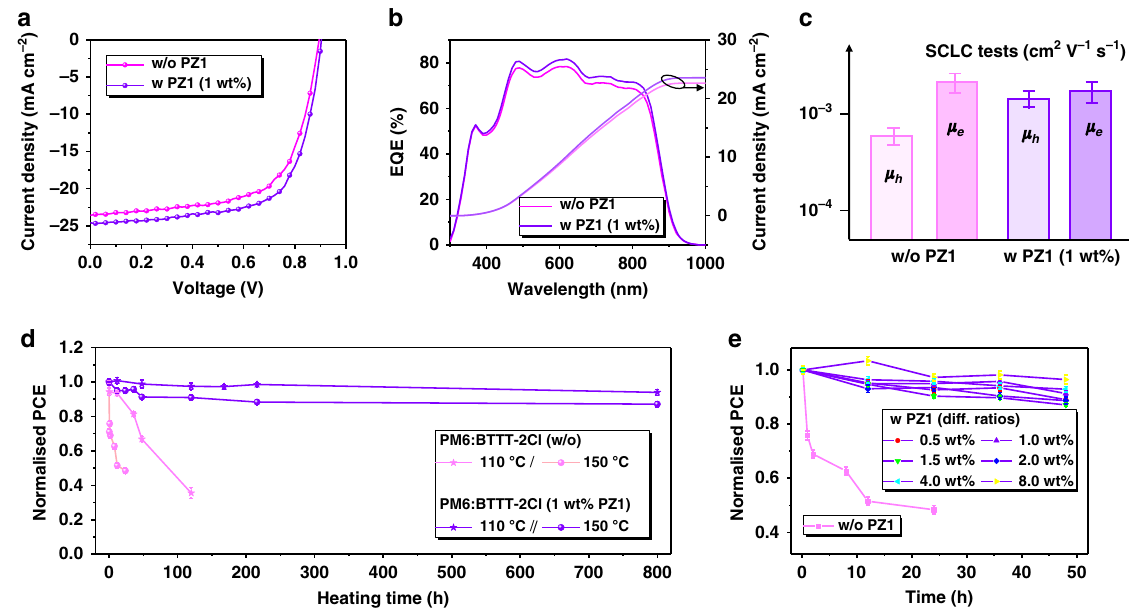
Fig. 2 Photovoltaic performance and thermal stability of the blends. a J – V curves of the champion devices fabricated without and with 1 wt% PZ1. b EQE spectra and integrated current densities from the EQE spectra. c Hole- and electron-only mobilities of relevant devices without and with 1 wt% PZ1. d Normalized photovoltaic performance of the investigated PM6:BDTTT-2Cl blends without and with 1 wt% PZ1 as a function of annealing time at 150 °C and 110 °C, respectively. e Normalized PCE of corresponding blends with different PZ1 concentrations as a function of annealing time at 150 °C. Source data are provided as a Source Data fi le. Table 1 Detailed photovoltaic parameters and carrier mobilities of the relevant